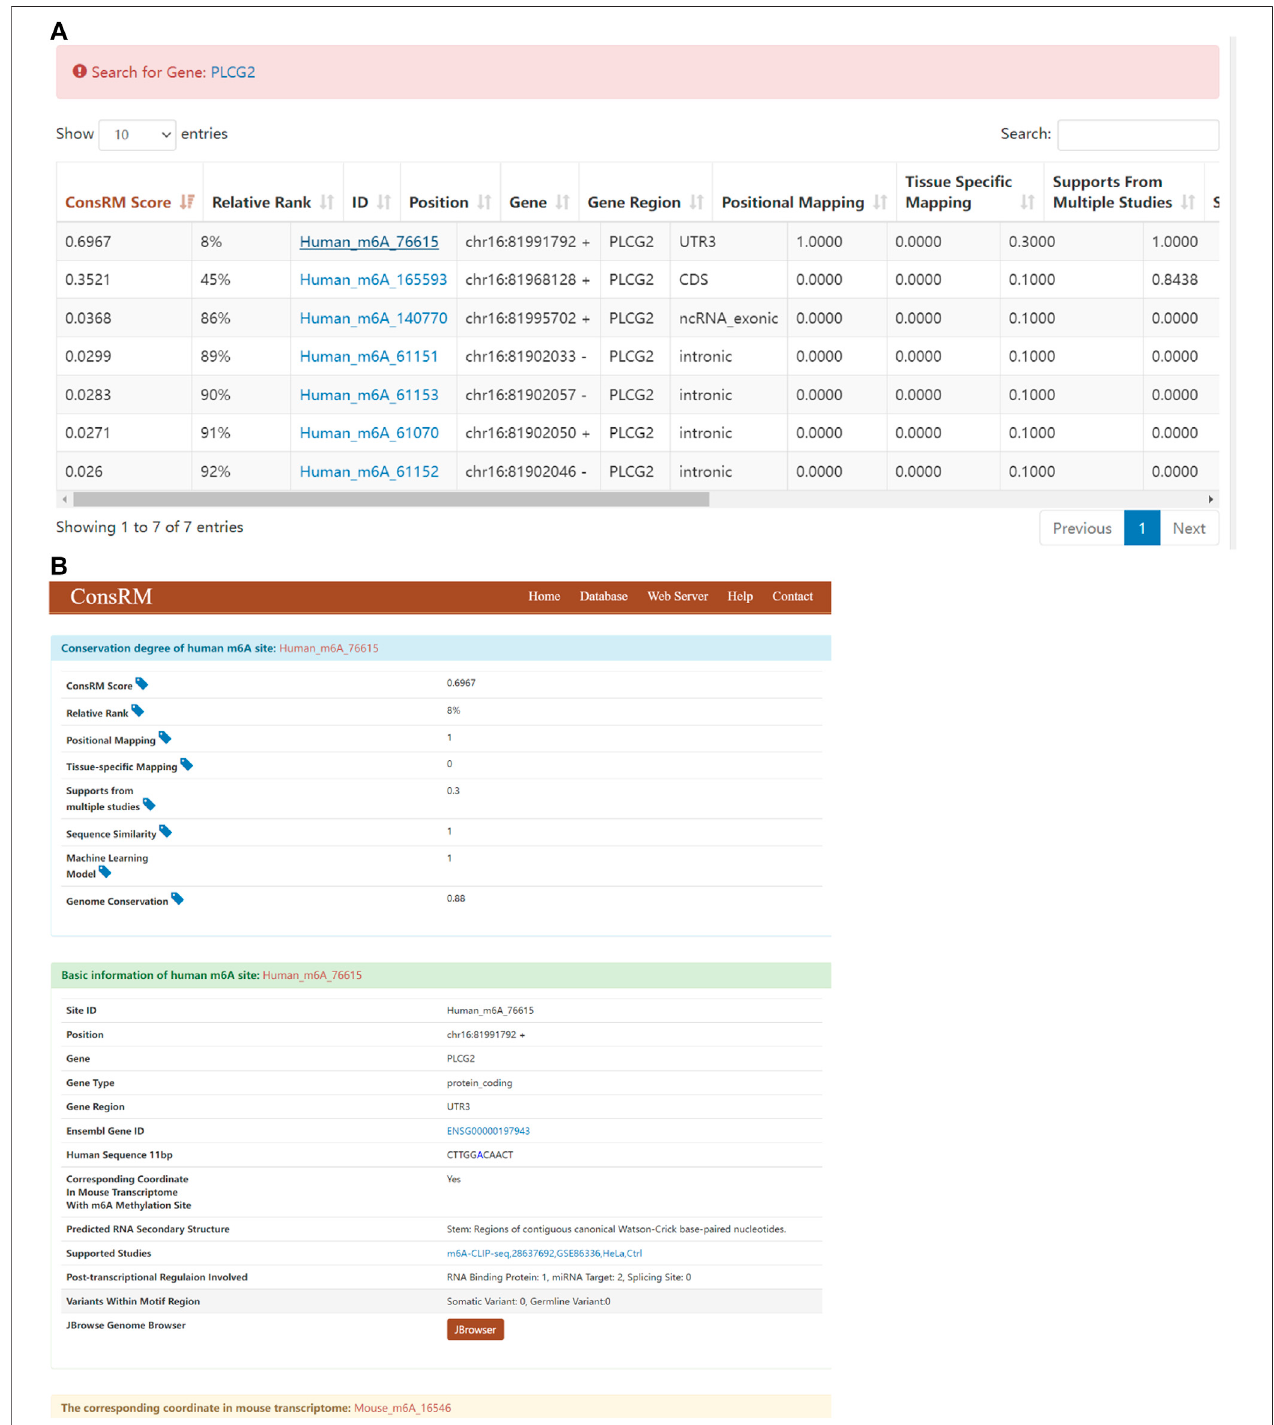
FIGURE 10 | Results of ConsRM online platform. (A) Search for “ PLCG2 ” returns 7 m 6 A sites. (B) The detailed conservation metrics and other regulatory information of the most conserved m 6 A site on PLCG2.